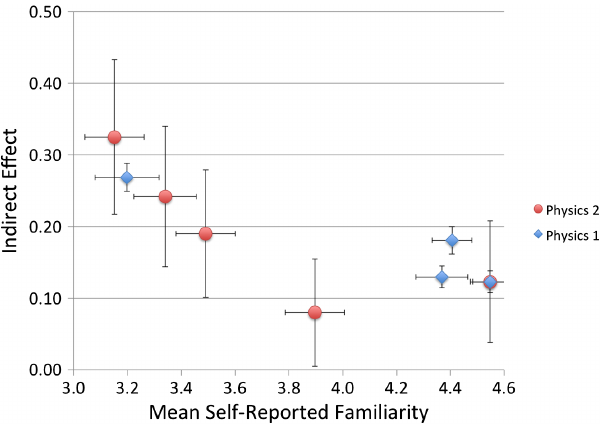
FIG. 3. Horizontal: Mean self-reported familiarity with each physical context from Table V. Vertical: Completely standardized indirect effect for each physical context from Table V. One standard error shown for both dimensions. Blue symbols re- present contexts presented to Physics 1 students. Red symbols represent contexts presented to Physics 2 students. Note that familiarity scores were obtained from a separate sample of Physics 2 students in a later